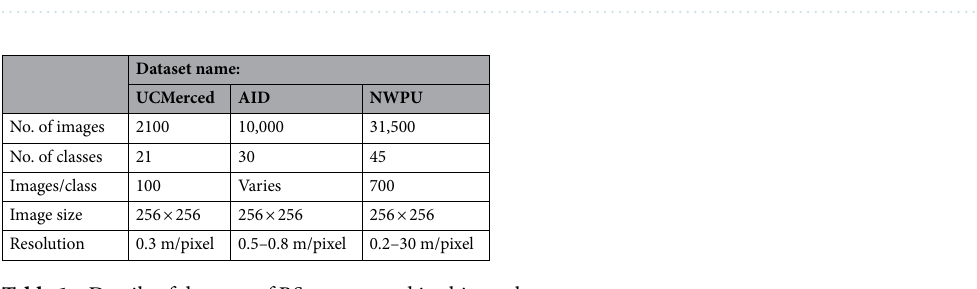
Table 1. Details of datasets of RS scenes used in this